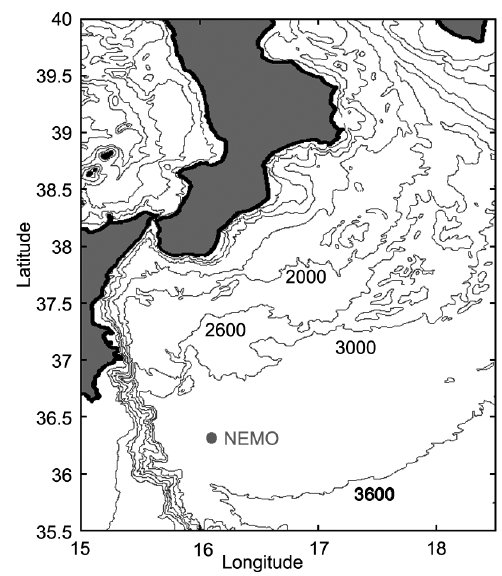
Fig. 3. The south Ionian Sea, showing the location of the site selected and characterized by the NEMO collaboration for the installation of the km 3 neutrino